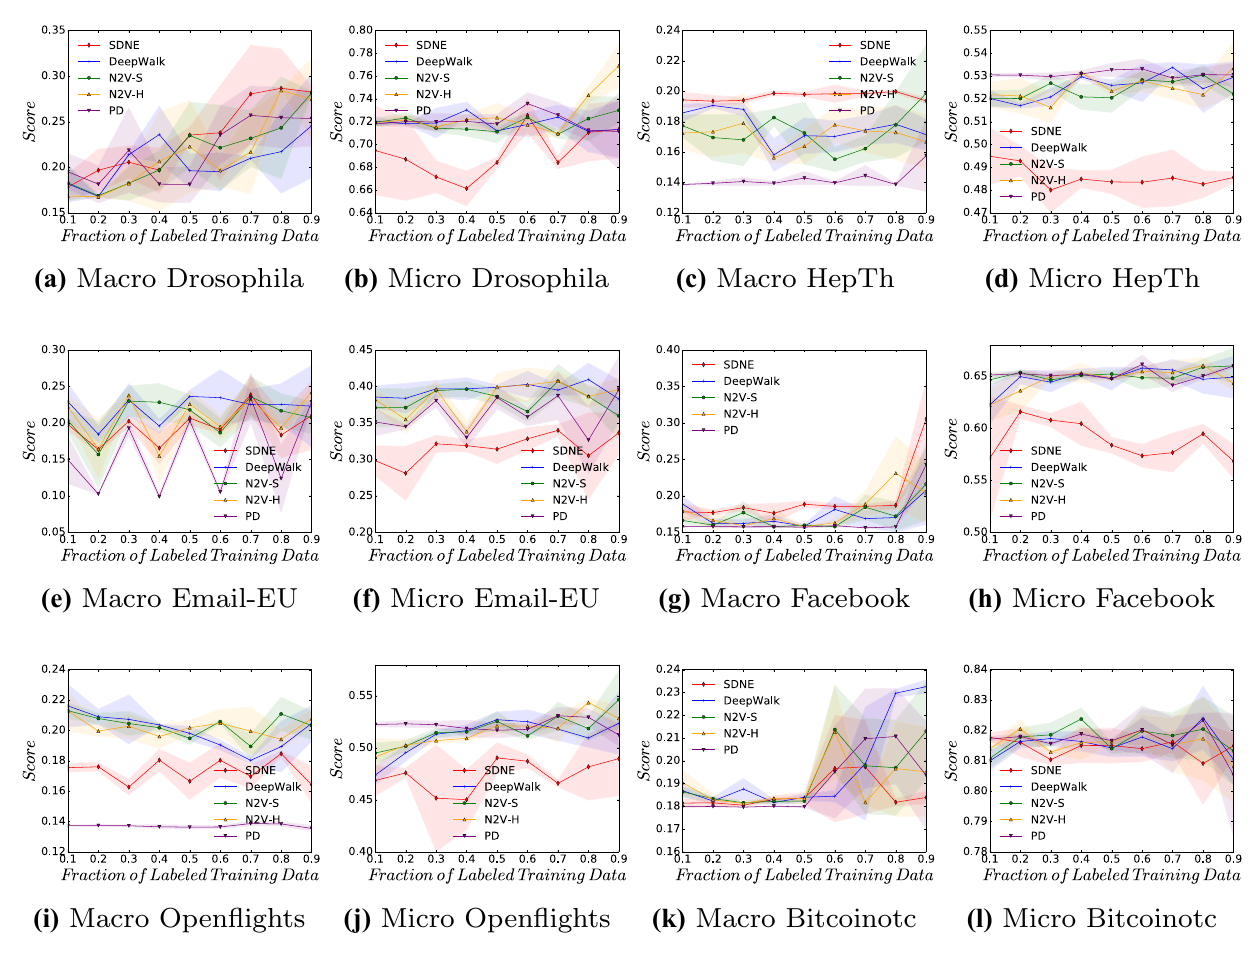
Fig. 7 Micro-f1 and macro-f1 scores, across a range of labelling fractions, for all approaches when predicting a vertex’s PageRank (PR) value across all